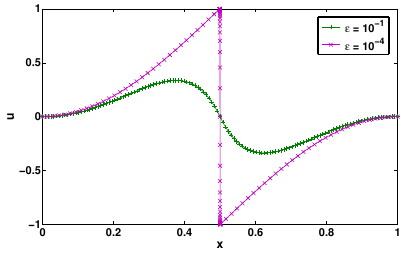
Figure 1. Exact solution for Example 1 on the mesh Ω N for N =